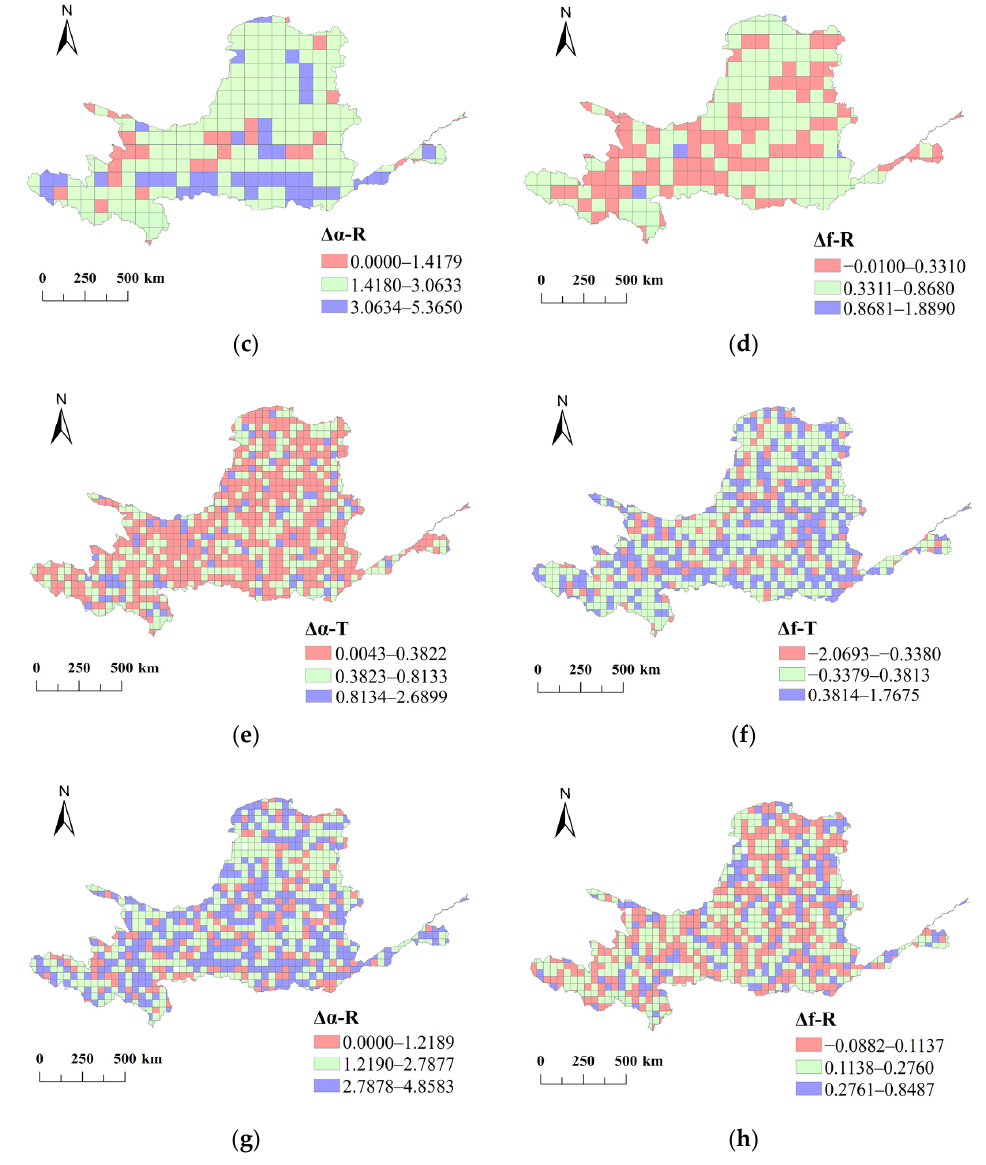
Figure 2. Multifractal characteristics of Yellow River Basin. ( a ) ∆𝛼 of an 80 × 80 km grid topography; ( b ) ∆𝑓 of an 80 × 80 km grid topography; ( c ) ∆𝛼 of an 80 × 80 km grid river network; ( d ) ∆𝑓 of an 80 × 80 km grid river network; ( e ) ∆𝛼 of a 40 × 40 km grid topography; ( f ) ∆𝑓 of a 40 × 40 km grid topography; ( g ) ∆𝛼 of a 40 × 40 km grid river network; ( h ) ∆𝑓 of a 40 × 40 km grid river network.